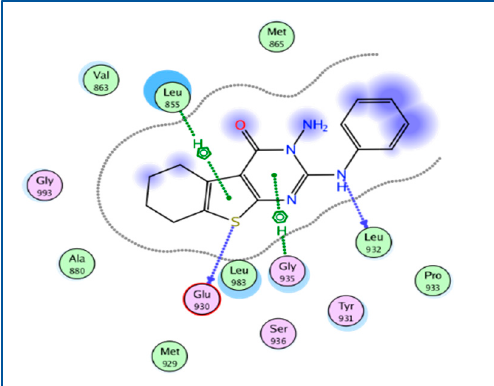
Figure 3. Prepared compound 3 2D interaction at PDB: 3ZMM with H-bond at Glu 930 and 932, and H- pi interaction at Glu 935 and 855.